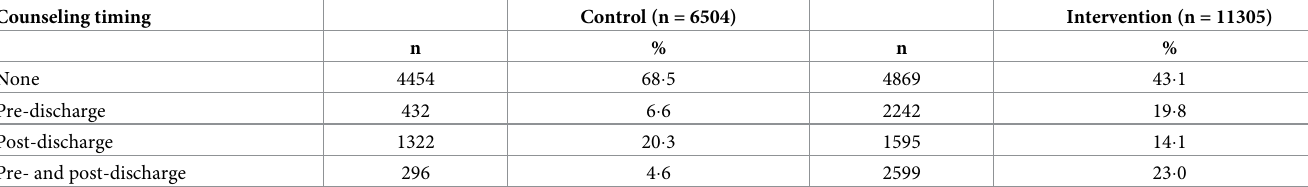
Table 3. Number and percentage of women who received counseling at year two postpartum, by intervention arm. Counseling